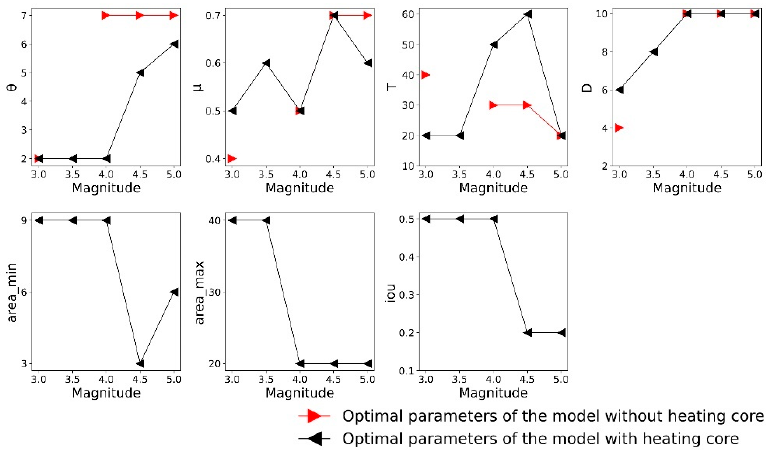
Figure 9. The optimal parameters of the models with/without a “heating core” when the moving window size is 50 under different magnitude parameters.